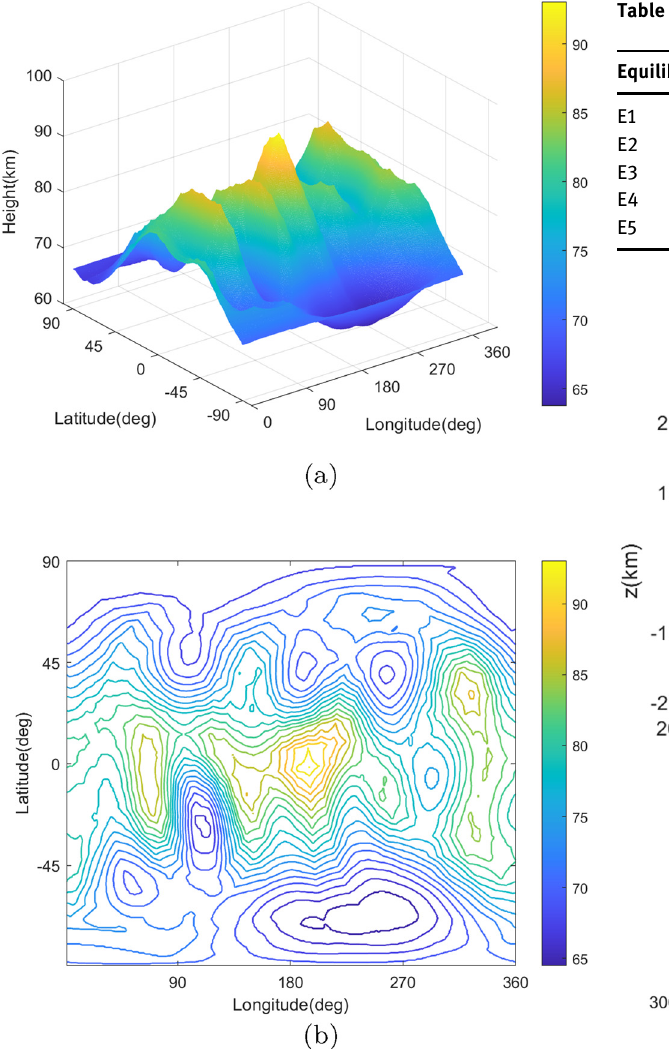
Figure 3: Surface height of Minerva, and the units on the colorbar are km. ( a ) 3D plot and ( b ) contour plot.